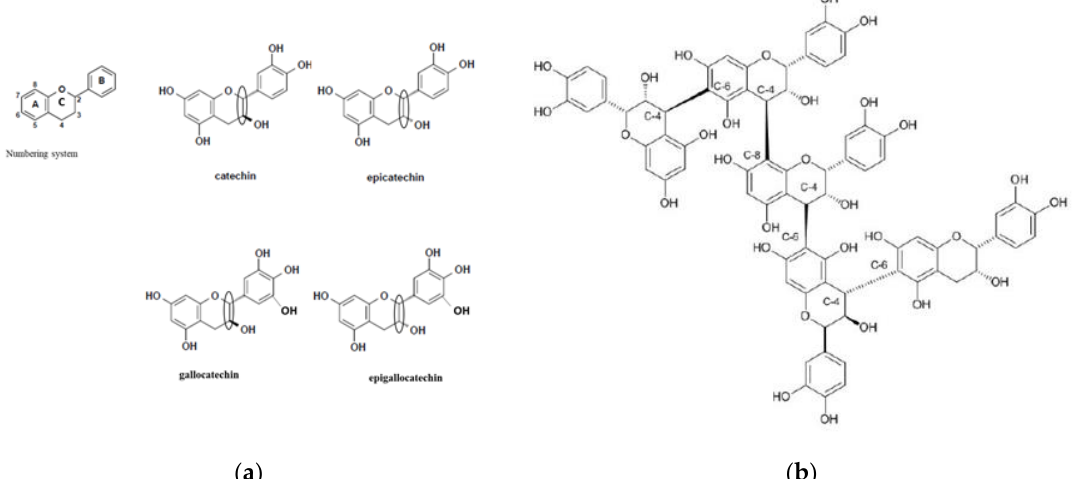
Figure 1. Subunits and interlinkage structures of flavan-3-ols occurring in condensed tannins, described as: ( a ) Procyanidin (catechin and epicatechin) and prodelphinidin (gallocatechin and epigallocatechin) condensed tannin subunits; and ( b ) 4,8- and 4,6-B-type interflavan linkage in condensed tannin oligomers and polymers. Source [14,26].